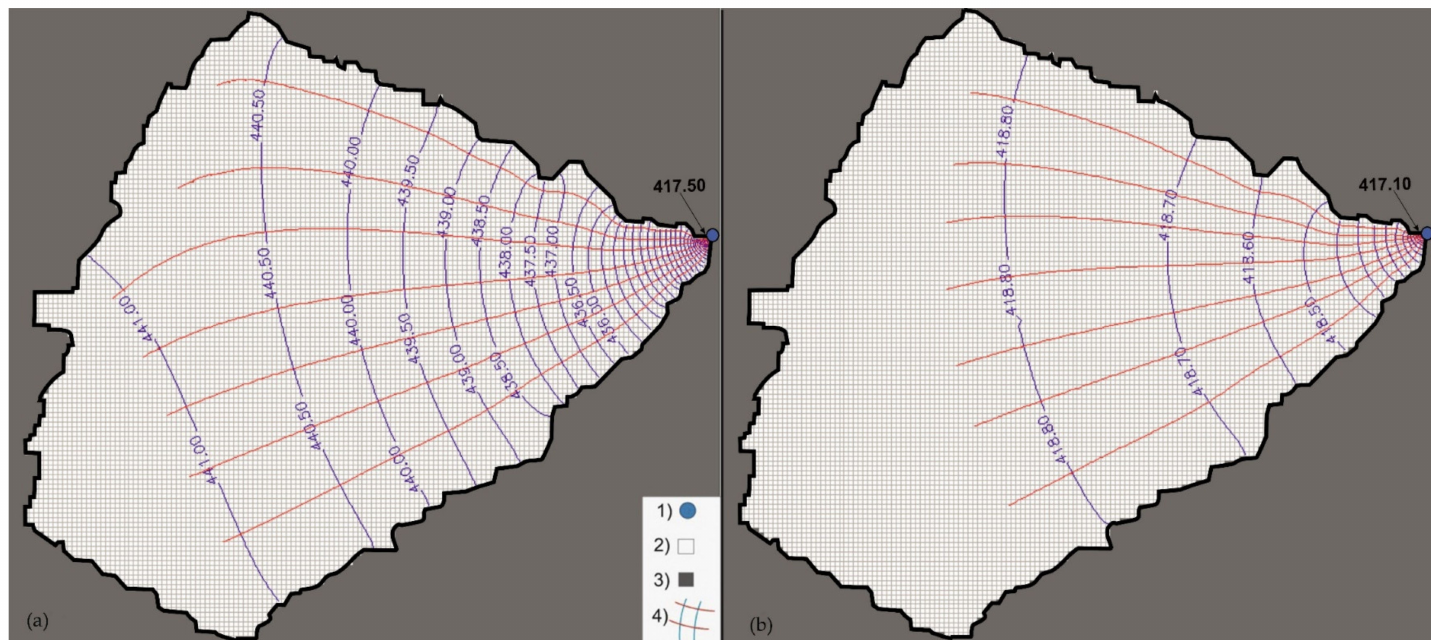
Figure 9. Plan-view of the Caposele unconfined aquifer under steady-state conditions during the mean recharge period (R = 1.06 m / y), cell size 100 × 100 m, K mean = 4.8 × 10 − 3 m / s and thickness of the saturated zone of the aquifer (TSZ): ( a ) 100 m, equipotential lines spaced at 0.5 m; and ( b ) 2000 m, equipotential lines spaced at 0.1 m. (1) spring; (2) active cell; (3) inactive cell and (4) flow